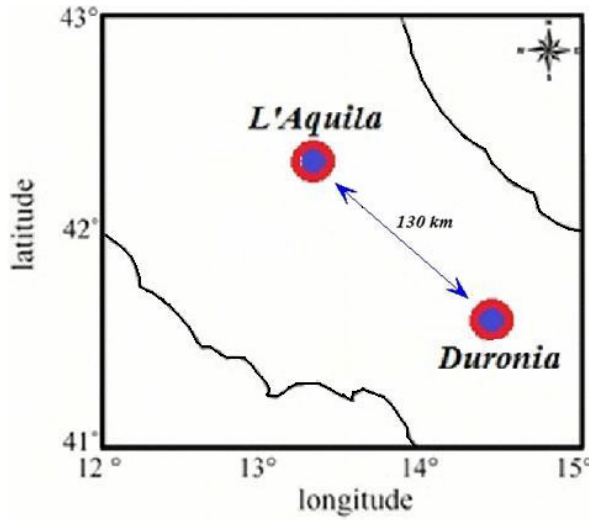
Fig. 5. Geographical location of the two observatories AQU and Fig. 5 Geographical location of the two observatories AQU and DUR